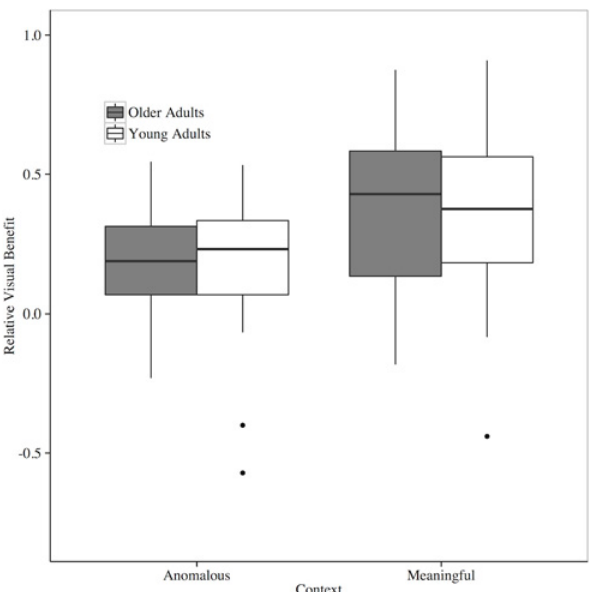
Fig 4. Relative visual benefit of older and younger adults in meaningful and anomalous semantic contexts at -12 SNR. Bars represent upper and lower limits of the sample data, box limits represent upper and lower quartile, and the heavy line represents the sample median.